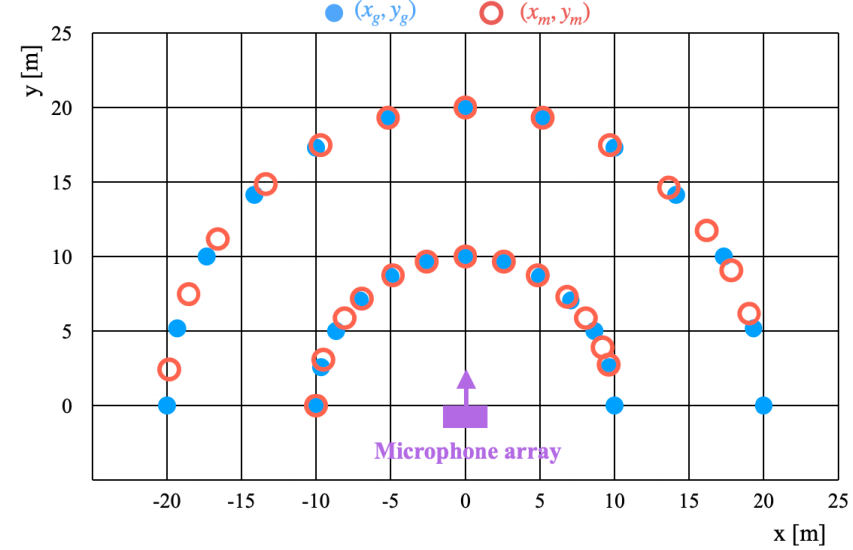
Figure 9. Comparative positional distributions between ( x g , y g ) and ( x m , y m ) found from Experi- ment